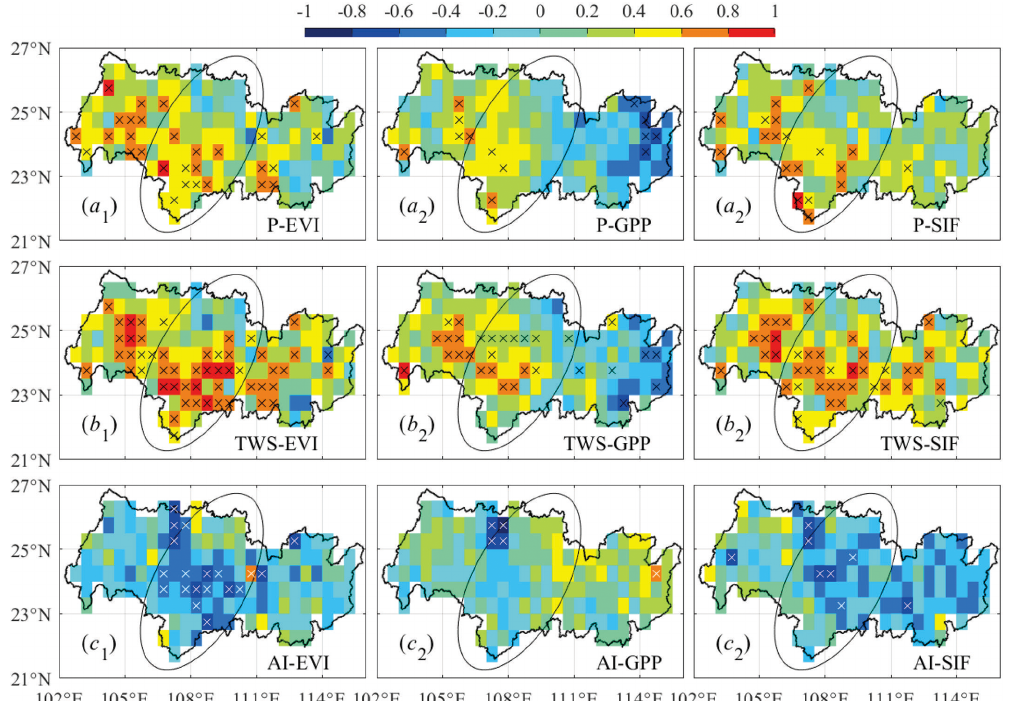
Figure 6. Pearson correlation coefficient between annual anomalies of ( a 1 –a 3 ) precipitation, EVI, GPP, and SIF, ( b 1 –b 3 ) total water storage, EVI, GPP, and SIF, and ( c 1 –c 2 ) aridity index, EVI, GPP, and SIF. The ellipse marks the areas where croplands dominate. Crosses (black and white) indicate p < 0 .